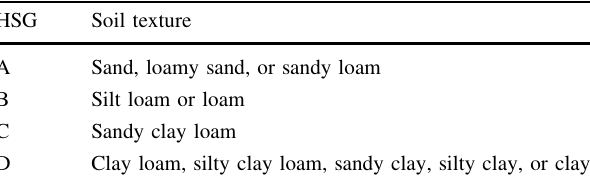
Table 1 Hydrologic soil groups by soil texture in the Xiang River Basin